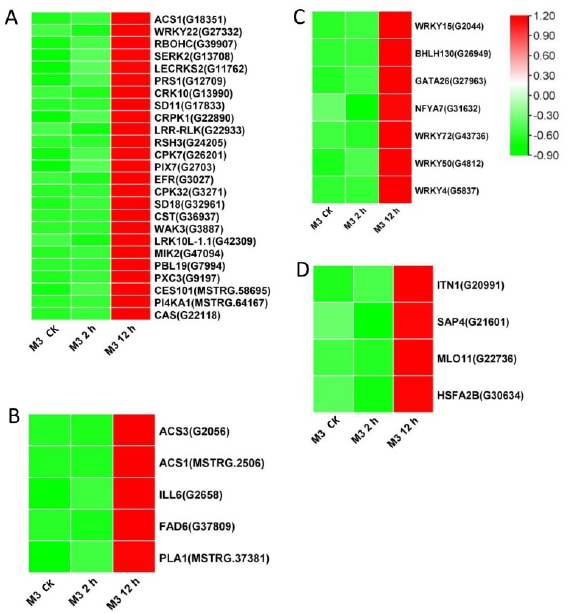
Figure 7. Heatmap of DEGs unique to M3 plants involved in Profile 4 in M3 plants. ( A ) Protein kinase and Ca 2+ signal-related genes, ( B ) hormone-related genes, ( C ) transcription factors, and ( D ) stress-related genes were identified. The sample and treatments are displayed at the bottom of each column. Relative expression levels are shown by a colored gradient, from low (green) to high (red). Scale bars represent the log 2 transformations of the RPKM values.